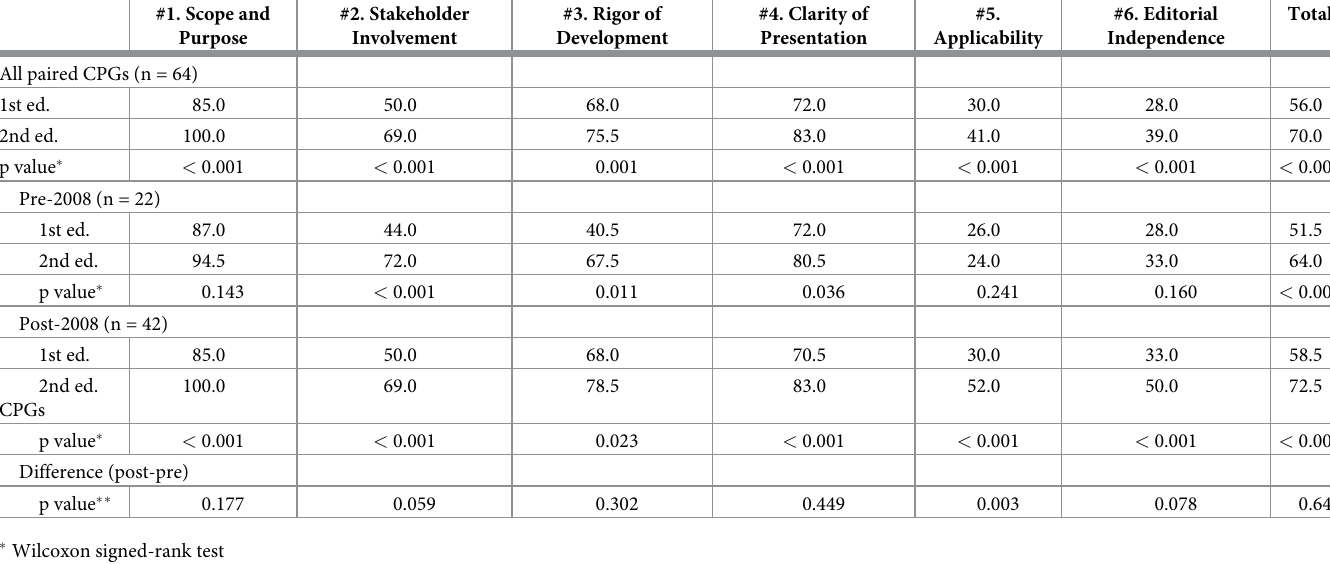
Table 2. Comparison of median scores of the first and second edition of clinical practice guidelines (n = 64). #1. Scope and Purpose